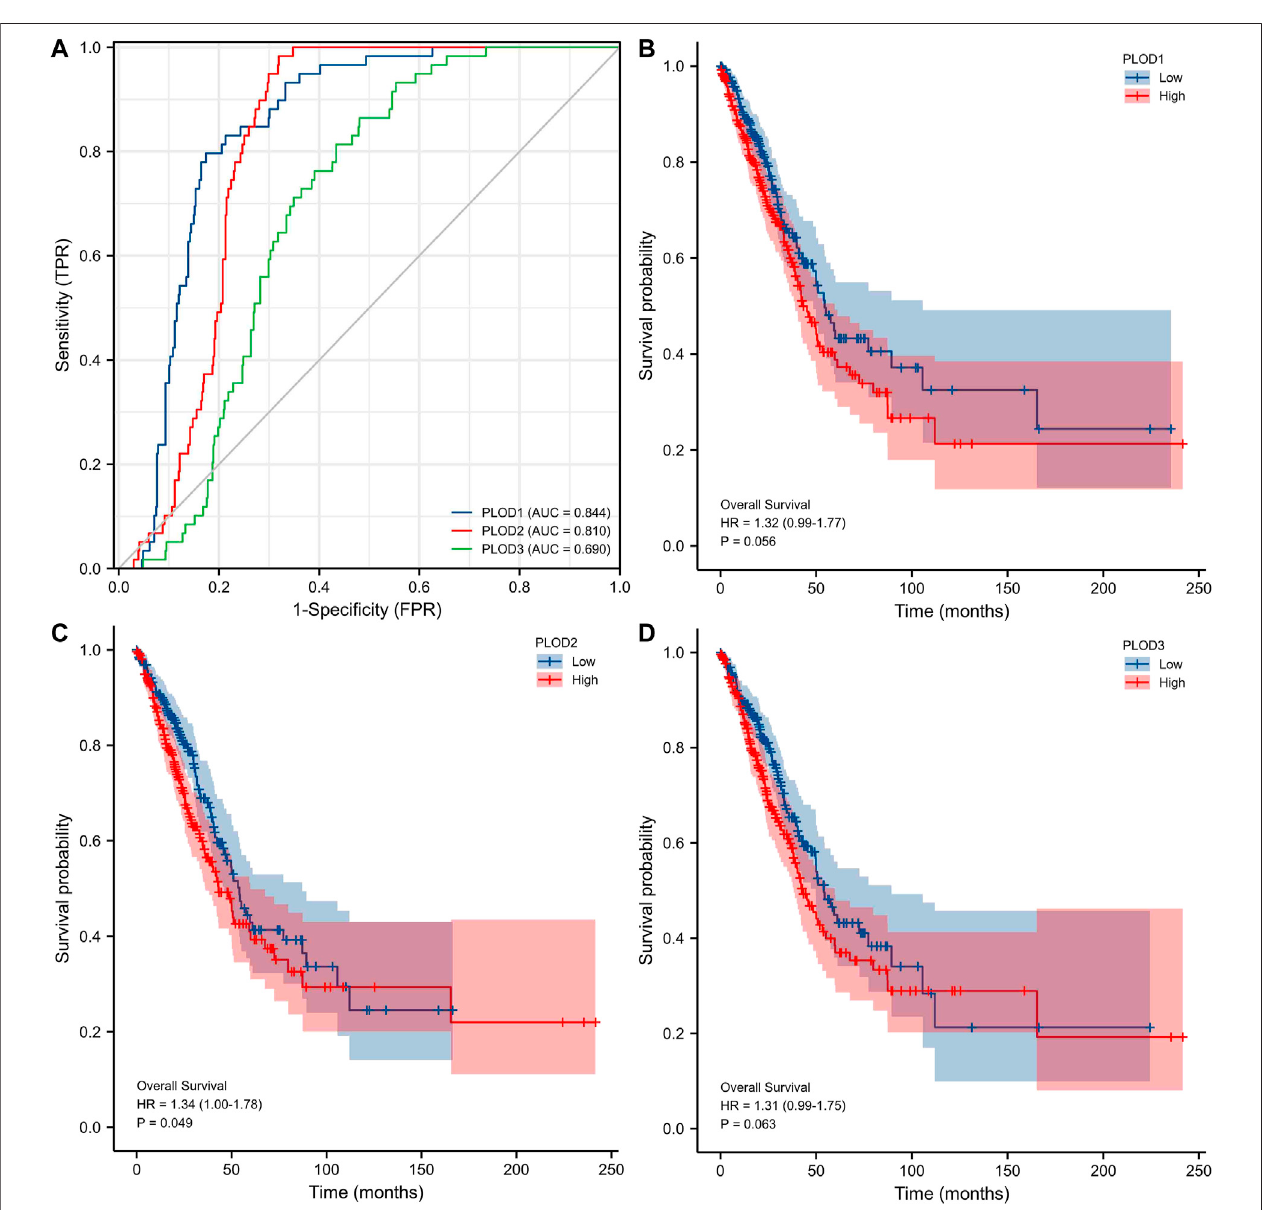
FIGURE 5 | Prospective biomarkers for distinguishing LUAD from normal samples. The survival ROC package in the R language was used to generate the ROC curve. (A) ROC curve showing that PLOD1 and PLOD2 can distinguish lung adenocarcinoma tissue from healthy controls. (B – D) The Kaplan – Meier curve of the PLOD gene family showed that the OS of LUAD patients with high PLOD2 mRNA expression was shorter than that of patients with low PLOD2 , and the difference was statistically signi fi cant.